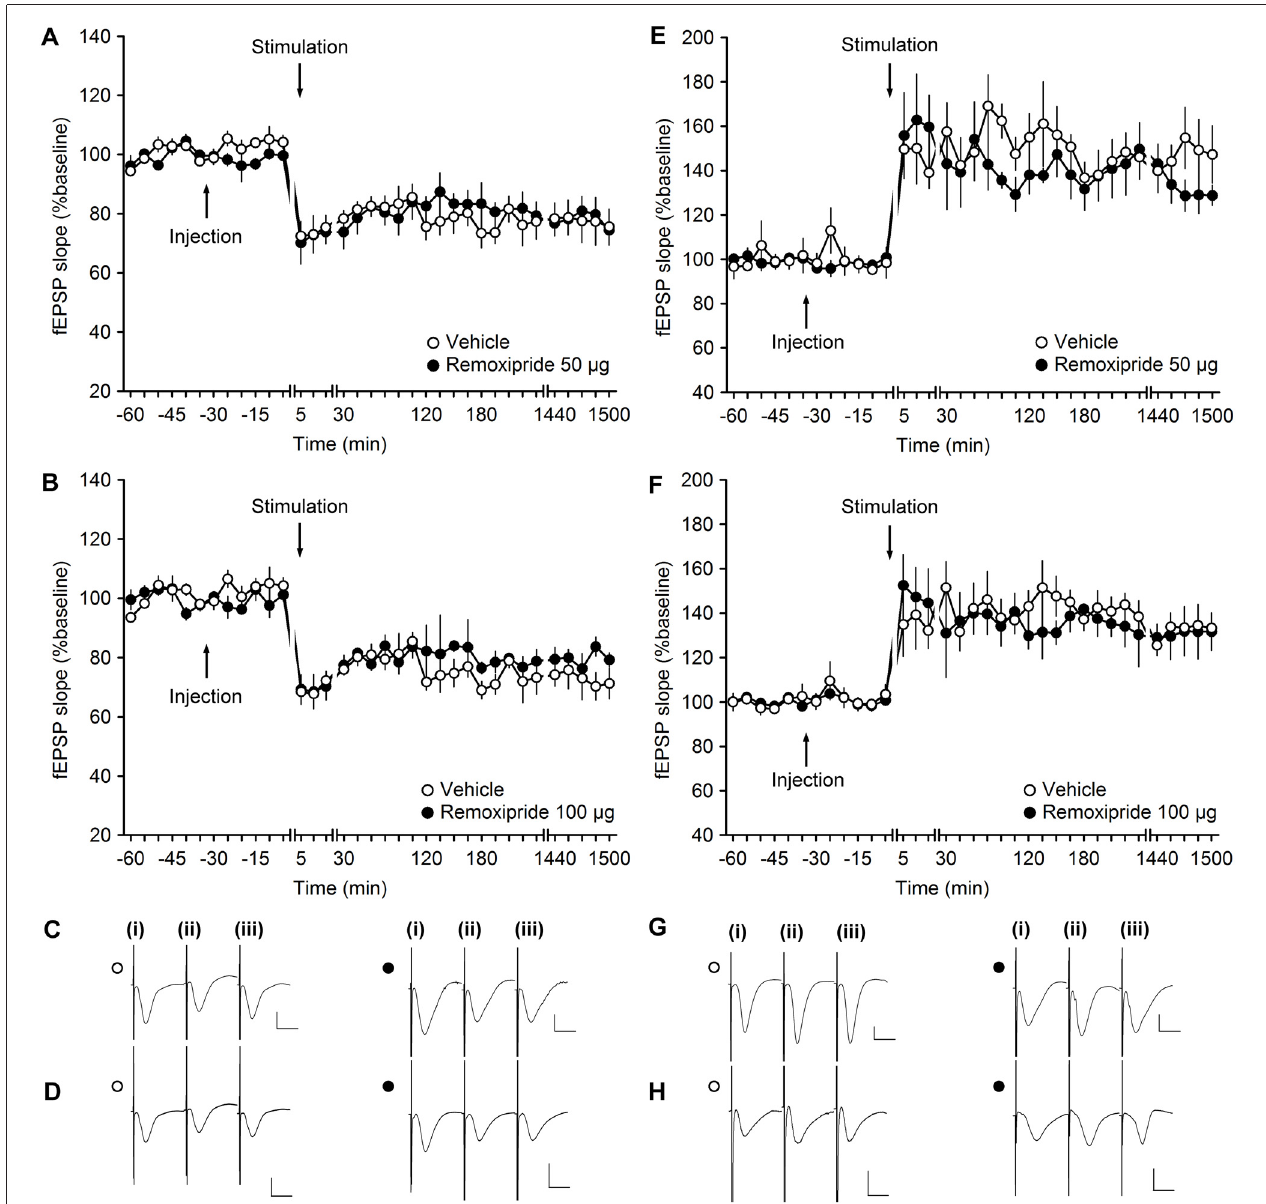
FIGURE 2 | The D2/D3-receptor antagonist remoxipride does not affect long-term plasticity at mossy fiber (MF)-CA3 synapses. (A,B) Vehicle-treated animals that received low-frequency stimulation (LFS, 1 Hz, 900 pulses) showed robust long-term depression (LTD) that lasted for over 25 h. LFS in the presence of remoxipride in the doses of 50 µ g (A) or 100 µ g (B) expressed long-term potentiation (LTP) that was not significantly different from controls. (C,D) Analogs from an LTD experiment that show responses recorded in vehicle-treated animals (open circle) and in animal treated with Remoxipride at a dose of 50 µ g (C) or 100 µ g ( D ; filled circle); (i) pre-LFS; (ii) post-LFS; and (iii) 24 h post-LFS. (E,F) High-frequency stimulation (HFS, 4 × 100 pulses at 100 Hz) resulted in robust LTP in vehicle-treated controls, that was unchanged by treatment of the animals with remoxipride in the doses of 50 µ g (E) or 100 µ g (F) . Line breaks indicate change